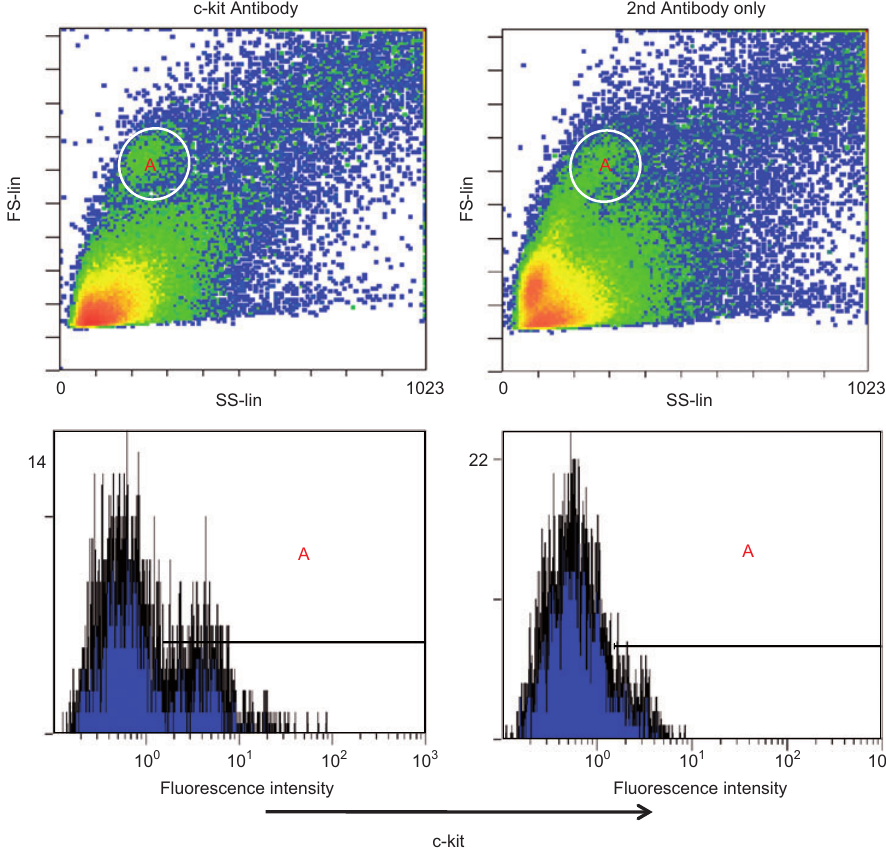
Figure 1 c-kit-positive cell population visualized by fl ow cytometry analysis. The small cells, the adult heart cells from which the cardiac myocytes were removed by centrifugation, were treated with the c-kit antibody and a secondary antibody, or a secondary antibody alone. Cells were subjected to forward scatter (FS) and side scatter (SS) analysis. Within the A region, a higher percentage of c-kit-positive cells was observed following treatment with the c-kit antibody and a secondary antibody than with the secondary antibody